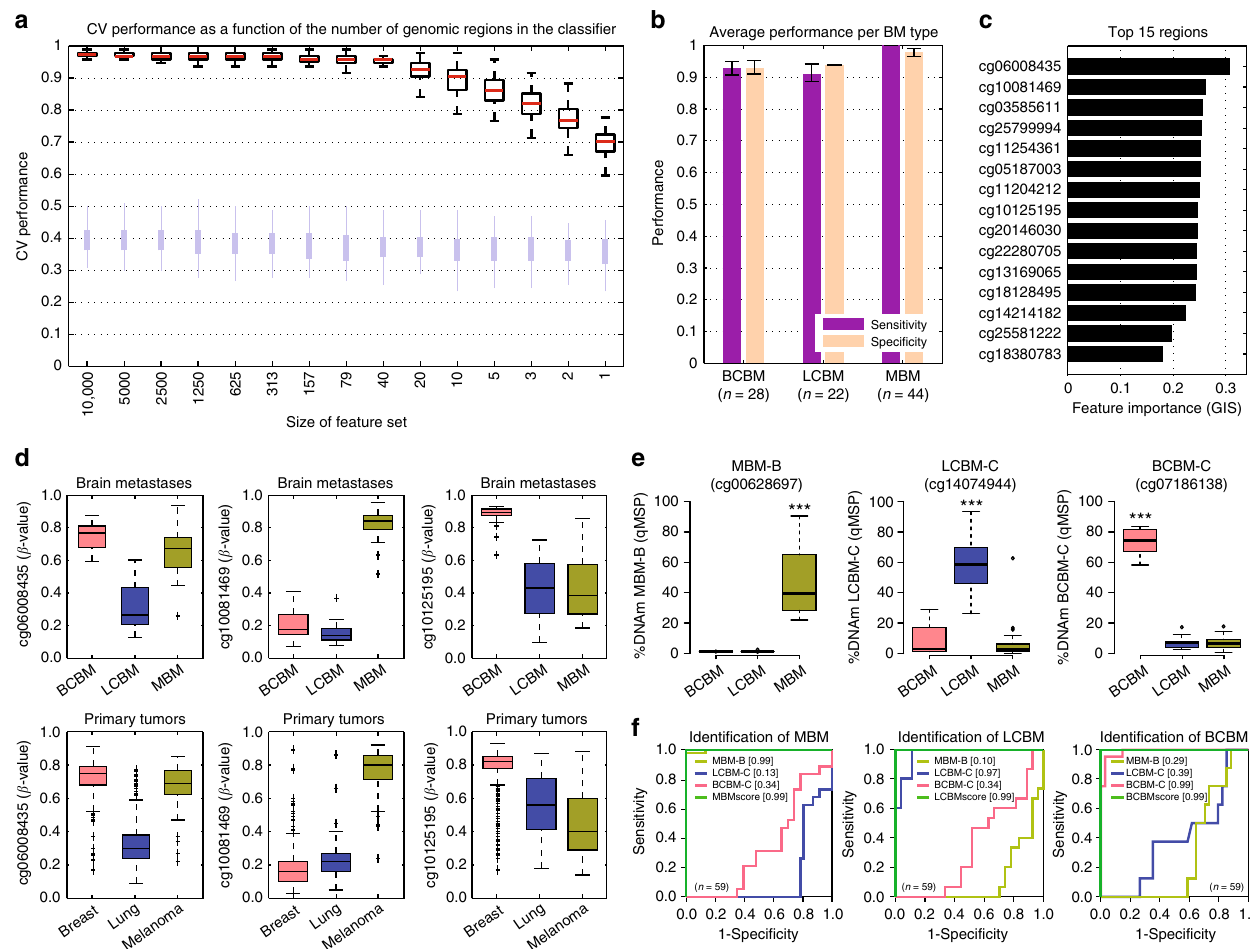
Fig. 3 DNA methylation classi fi ers to predict the tissue of origin of brain metastases. a CV performance across 100 repeats for the RF classi fi ers to predict tumor of origin, in order of decreasing number of features used in model construction, from left to right ( x -axis). Red bars on the boxplots indicate medians and light blue bars depict the performance based on permuted class labels and represent the random background distribution. b Bar plots depicting the prediction performance as measured by sensitivity and speci fi city for each of the BM types. The bars show the average performance and interquartile range (error bars) across all models with 40 features or more across all repeats. c Bar plots depicting the RF feature importance (mean decreases in Gini impurity score; GIS) of the 15 most predictive genomic regions averaged across all models with 40 features or more and across all repeats. d For three genomic regions in the top 15: boxplots of DNAm β -values across our cohort strati fi ed by tumor of origin (BCBM n = 28, LCBM n = 22, and MBM n = 44) in the upper panels and TCGA cohorts of primary breast tumors ( n = 401), primary lung tumors ( n = 307), and primary melanomas ( n = 83) in the lower panels. Differences in the DNAm levels among the groups were statistically signi fi cant for all the cases (Kruskal – Wallis test; P -value < 0.0001). e DNAm levels assessed by qMSP for three regions differentially methylated among the three BM types ( n = 59). The top and bottom of each box represent the fi rst and third quartile, respectively; the internal line represents the median. ***Wilcoxon test; P -value < 0.001. f ROC curves showing the prediction potential for the tumor of origin ( n = 59) for each of the differentially methylated regions and combinations into BM type-speci fi c scores: MBMscore = DNAm level of MBM-B minus DNAm level of LCBM-C minus DNAm level of BCBM-C; LCBMscore = DNAm level of LCBM-C minus DNAm level of BCBM-C minus DNAm level of MBM-B; and BCBMscore = DNAm level of BCBM-C minus DNAm level of LCBM-C minus DNAm level of MBM-B; see Supplementary Data 6 for details about these genomic regions. The AUC values are indicated between square